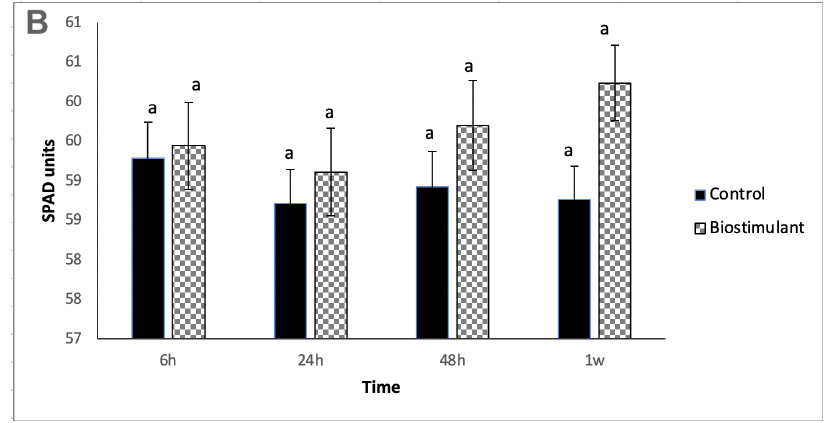
Figure 1. Chlorophyll Content and MSI percentage in banana leaves. ( A ) Chlorophyll content after foliar application of biostimulant and control (mock) treatment. ( B ) Percentage of MSI content after foliar application of biostimulant and control (mock) treatment. Letters a–c represents the statistics group differences between treatments.